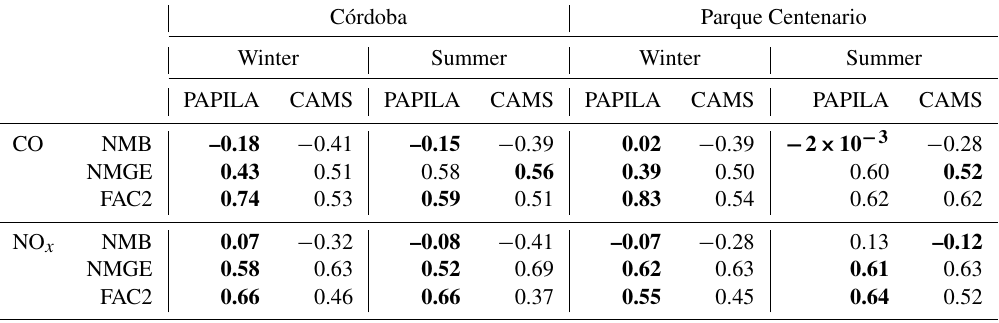
Table 3. Summary of statistical metrics used for evaluating model performance to simulate surface CO and NO x concentrations in PAPILA and CAMS experiments for both sites. The inventory with the best performance for each metric in each period is shown in bold.